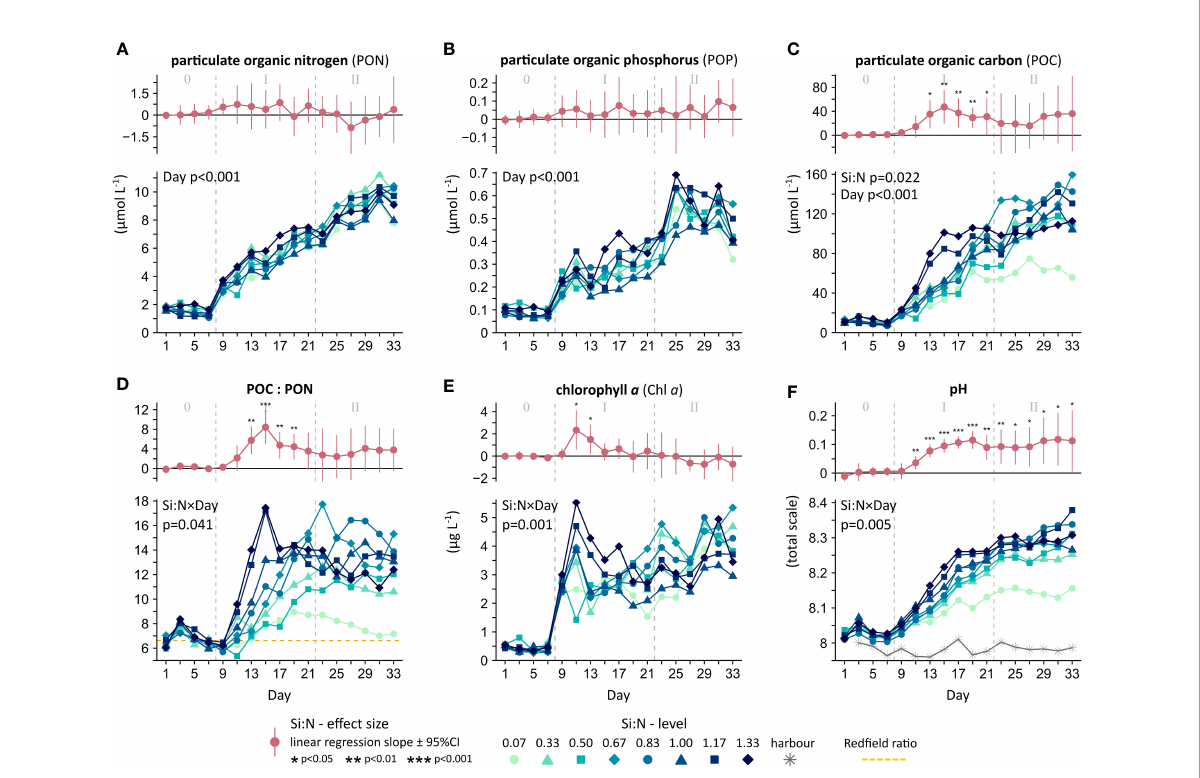
FIGURE 4 Biomass development under upwelling with varying deep water Si:N, including (A-D) particulate organic matter, (E) photosynthetic capacity, and (F) metabolic balance. Provided are the overall signi fi cances across time (Si:N, Day or Si:N×Day) and the daily Si:N effect (in red). Experimental phases: 0 = oligotrophic baseline, I = initial response, II = longer-term